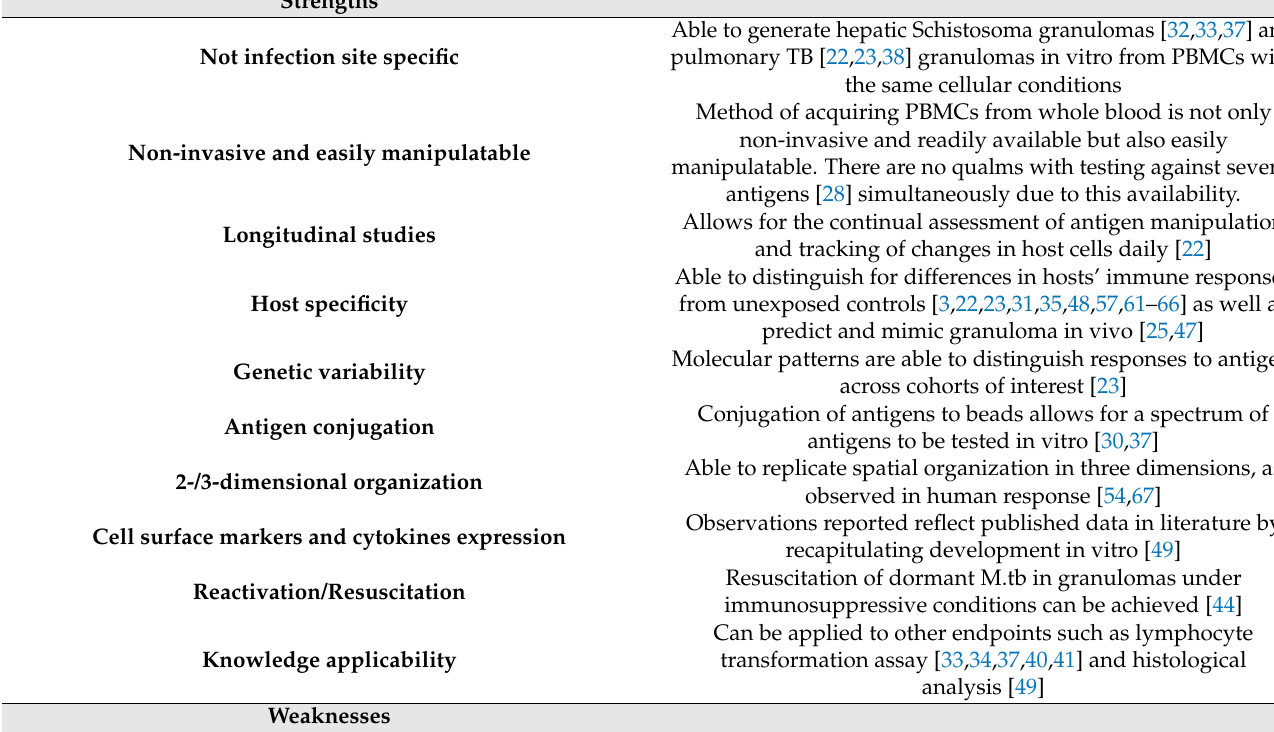
Table 2. Strengths and challenges of existing human in vitro granuloma